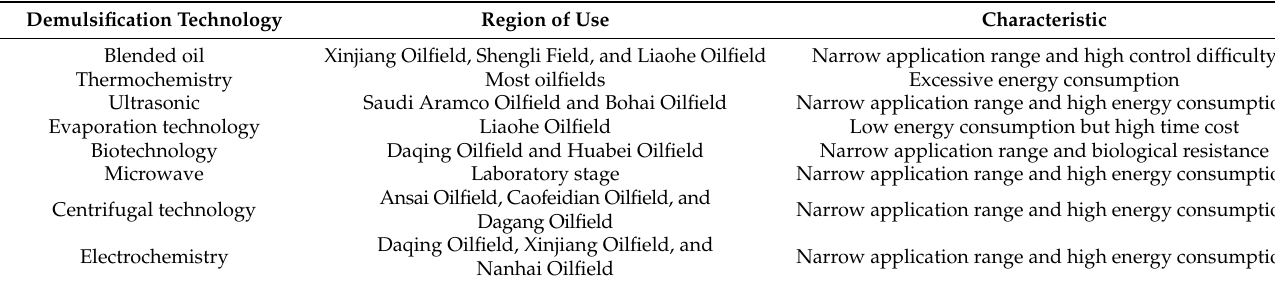
Table 1. Different demulsification technologies and their